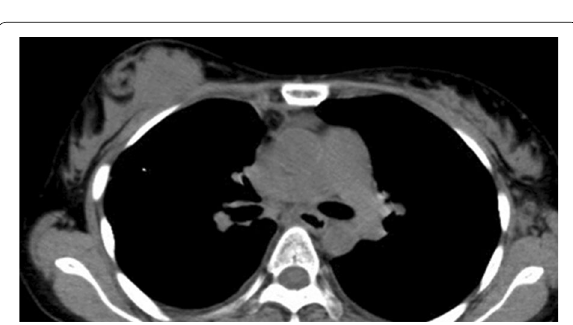
Fig. 6 Findings of computed tomography of case 3. A 45 mm-sized lesion with an equal density to soft tissue was observed in the upper area of the right